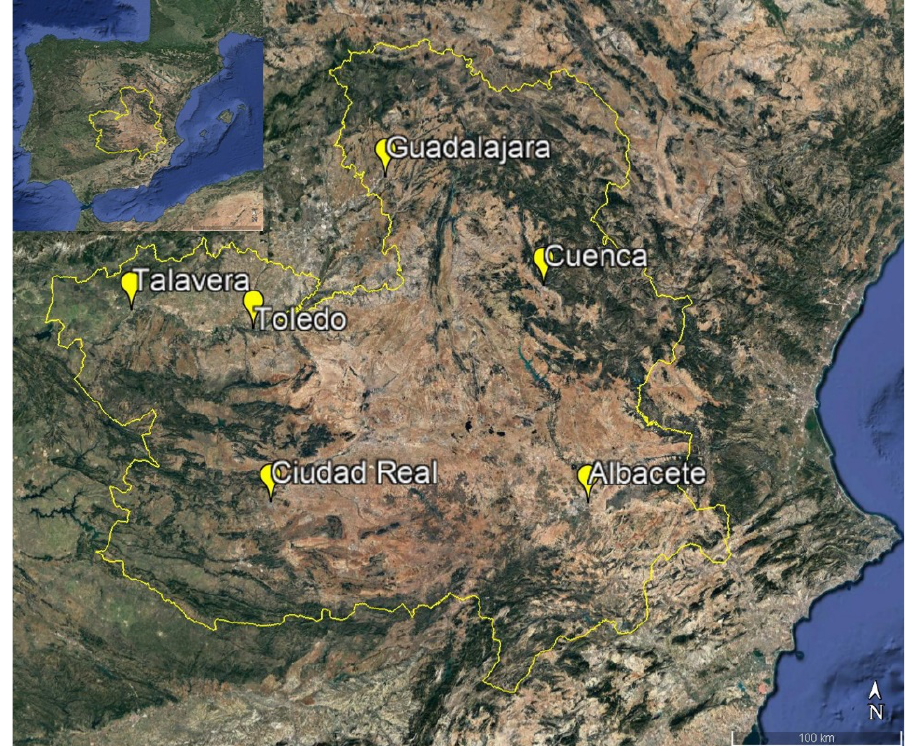
Figure 1. Location of the studied cities (source: GoogleEarth © ).